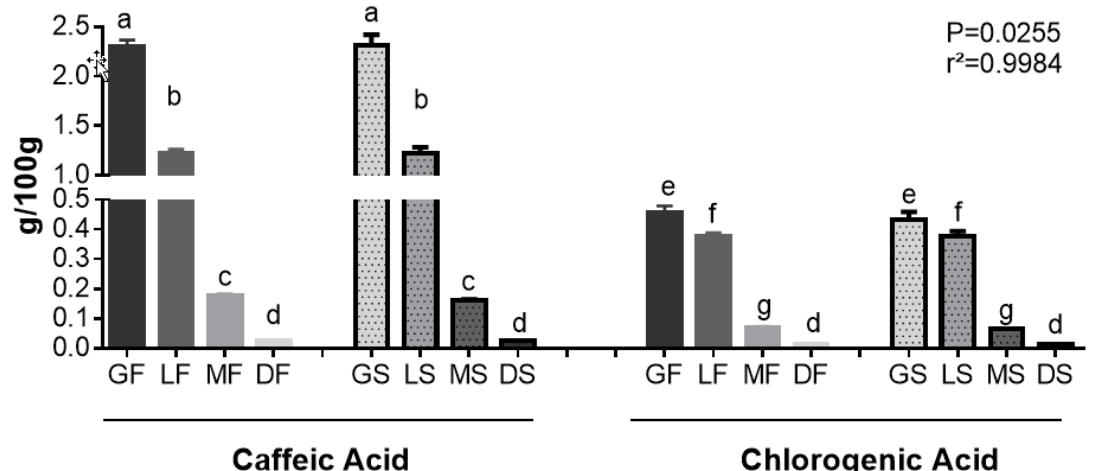
Figure 2. Caffeic and chlorogenic acids contents in the soluble extracts of green, light roasted, medium roasted and dark roasted Robusta coffee, submitted to freeze-drying and spray-drying. Different letters in the same analysis mean that samples are different ( p < 0.05) and same letters indicate the samples are the same ( p > 0.05). Abbreviations: GF—green freeze-dried, LF—light roasted